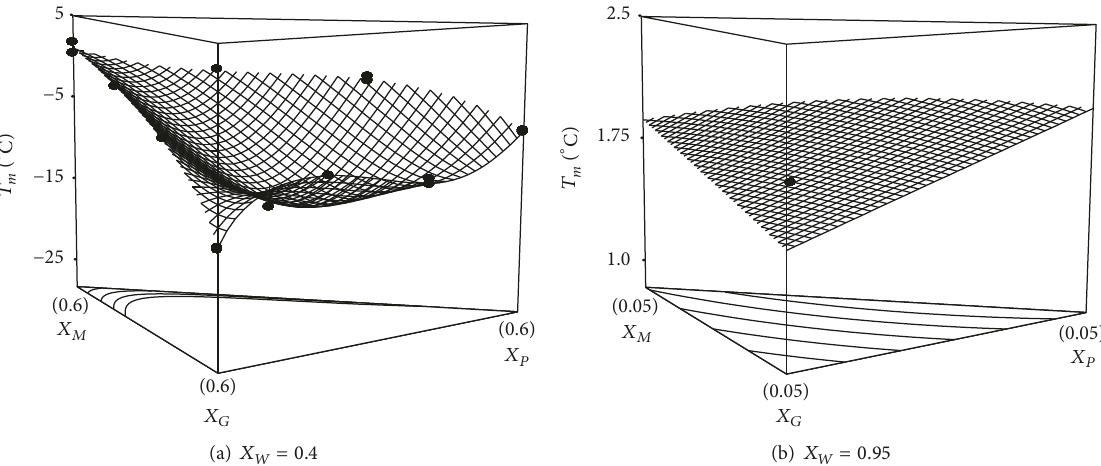
Figure 5: Response surface plots showing the variation of the experimental and predicted values of 𝑇 (a) 𝑋 = 0.4 and (b) 𝑋 = 0.95. e Experimental W W